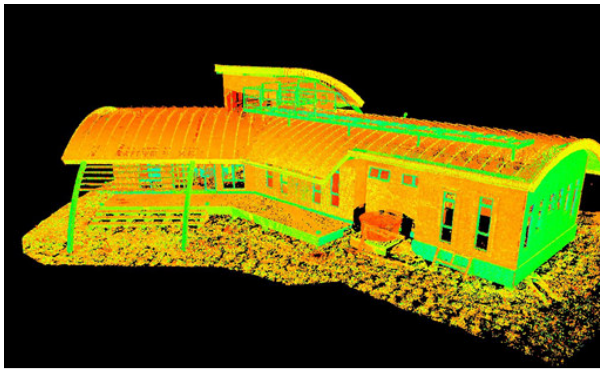
Figure 8. The façade of Eco-home building unify well and cleaning process is done to remove unnecessary points